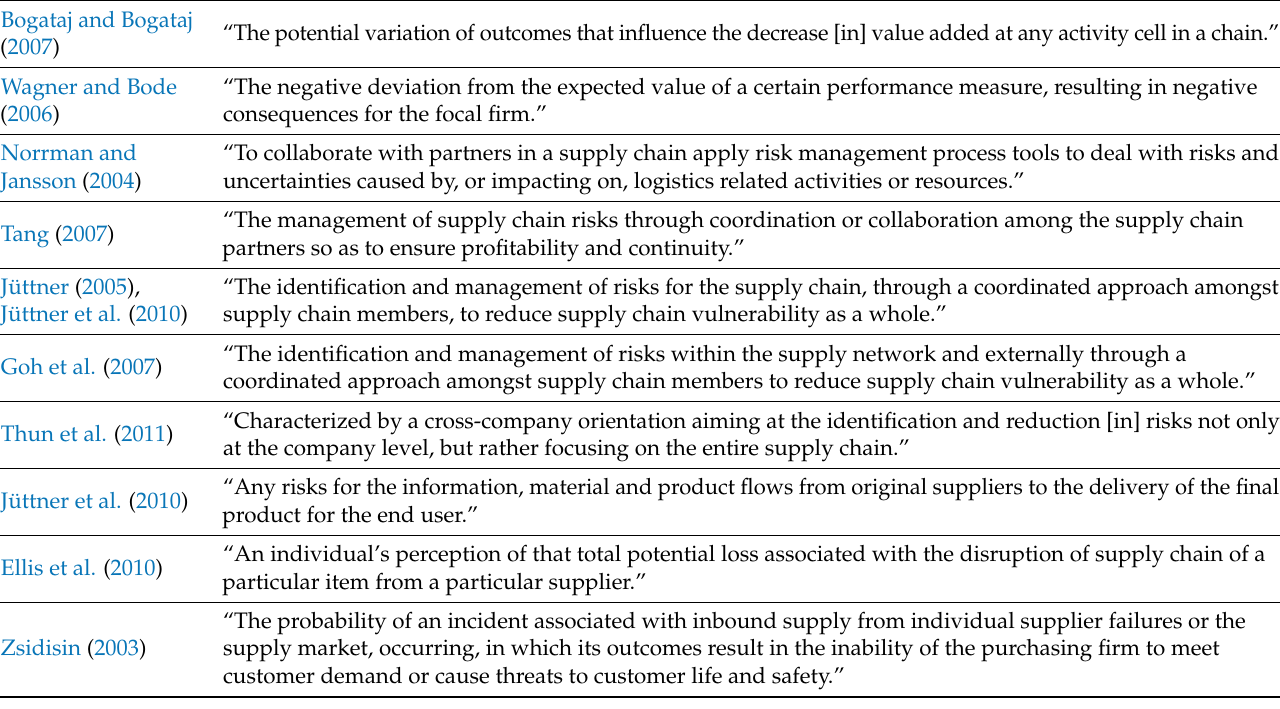
Table 1. Definitions of Risk and